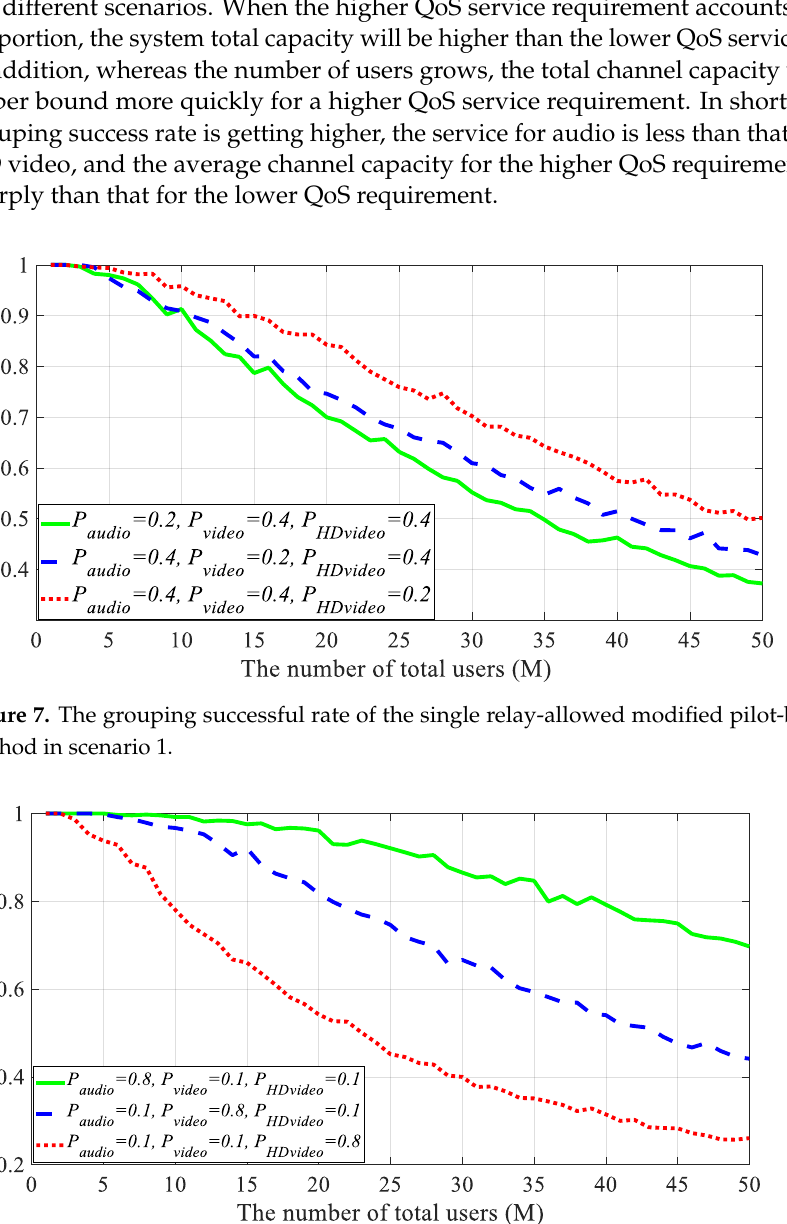
Figure 9. The grouping successful rate of the single relay-allowed modified pilot-based grouping method in scenario 3. Figure 10. The total system channel capacity of the single relay-allowed modified pilot-based group- ing method in scenario 1.